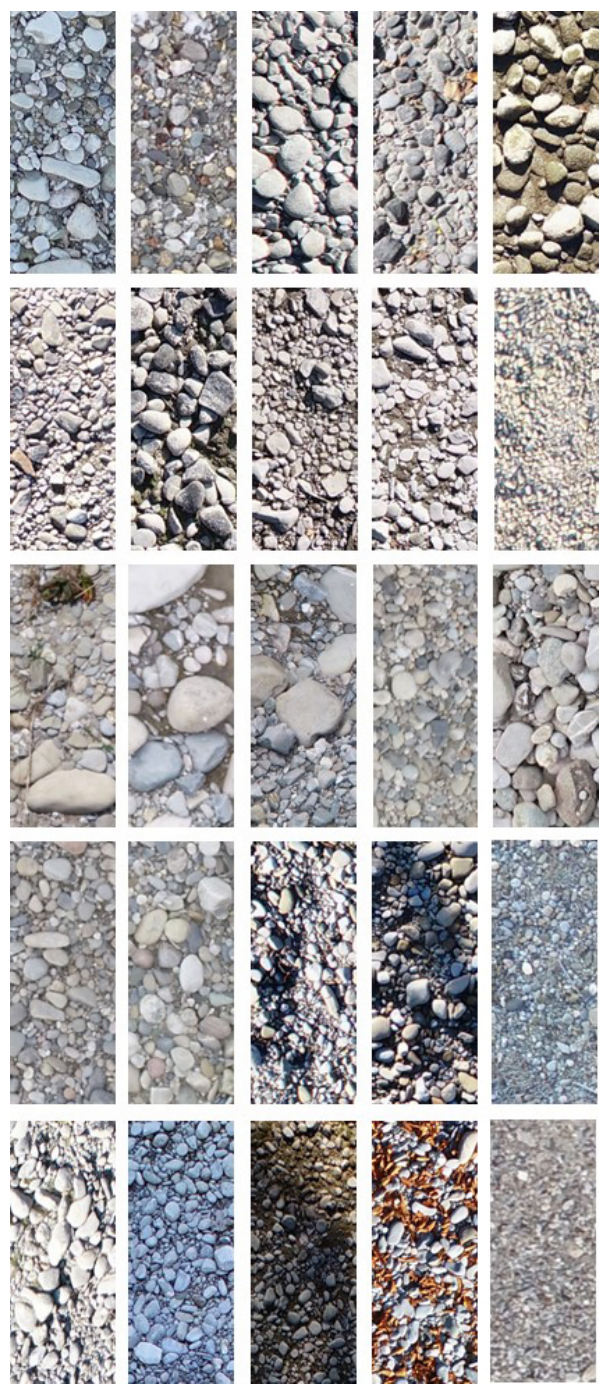
Figure 3. Example image tiles (1 . 25m × 0 . 5m) with 0.25cm ground sampling distance. Each of the 25 example tiles is taken from a different gravel